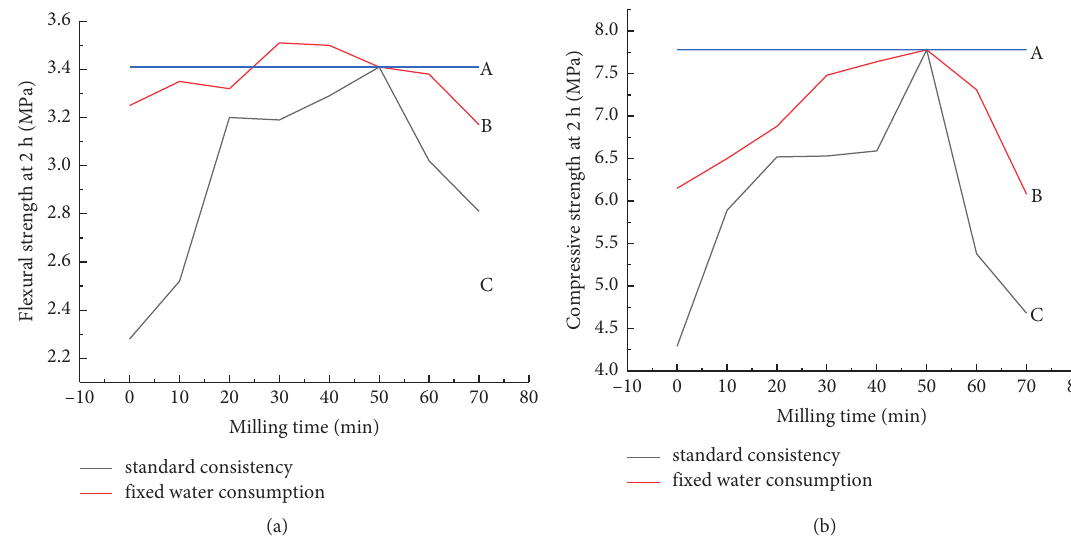
Figure 12: Trend of the strength of PBG at 2h. (a) Flexural strength (b) Compressive